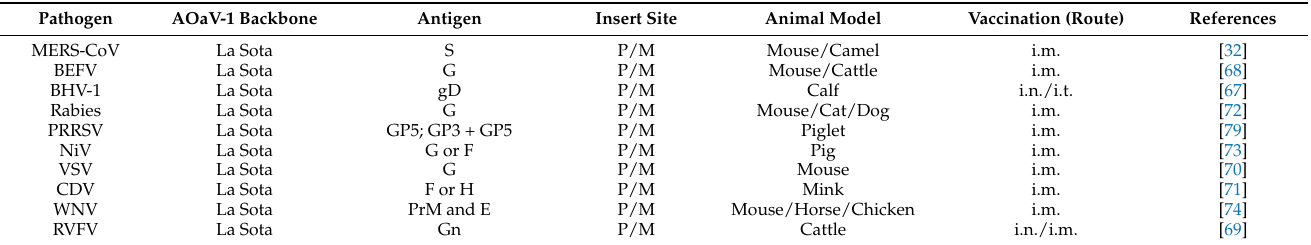
Table 2. Candidate AOaV-1-vectored vaccines for veterinary